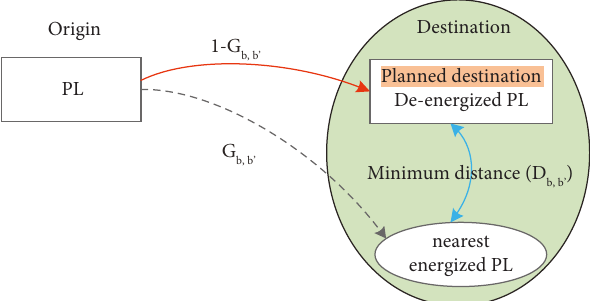
Figure 4: Ratio of PEV drivers that change their out-of-service destination to the nearest energized